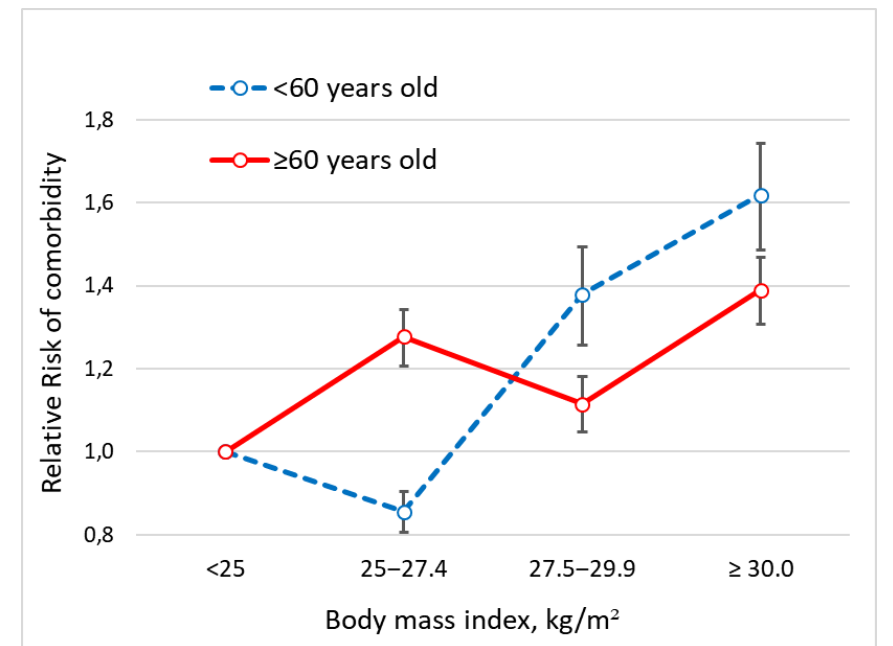
Figure 3. Association of BMI with the risk of comorbidity according to age.